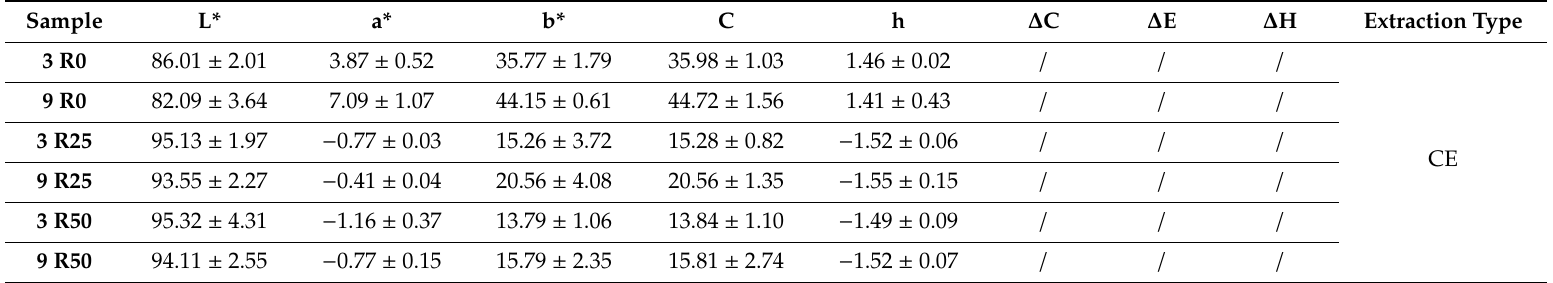
Table 4. International Commission on Illumination (CIE)—L*a*b* color parameters of CE and HVED treated rosemary extracts. Sample